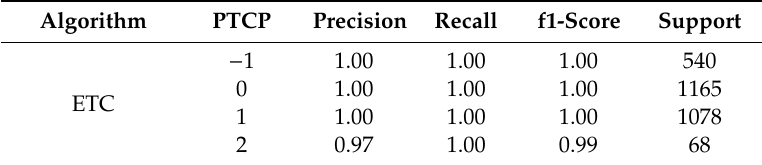
Table 9. Recursive Feature Elimination for the R scenario.